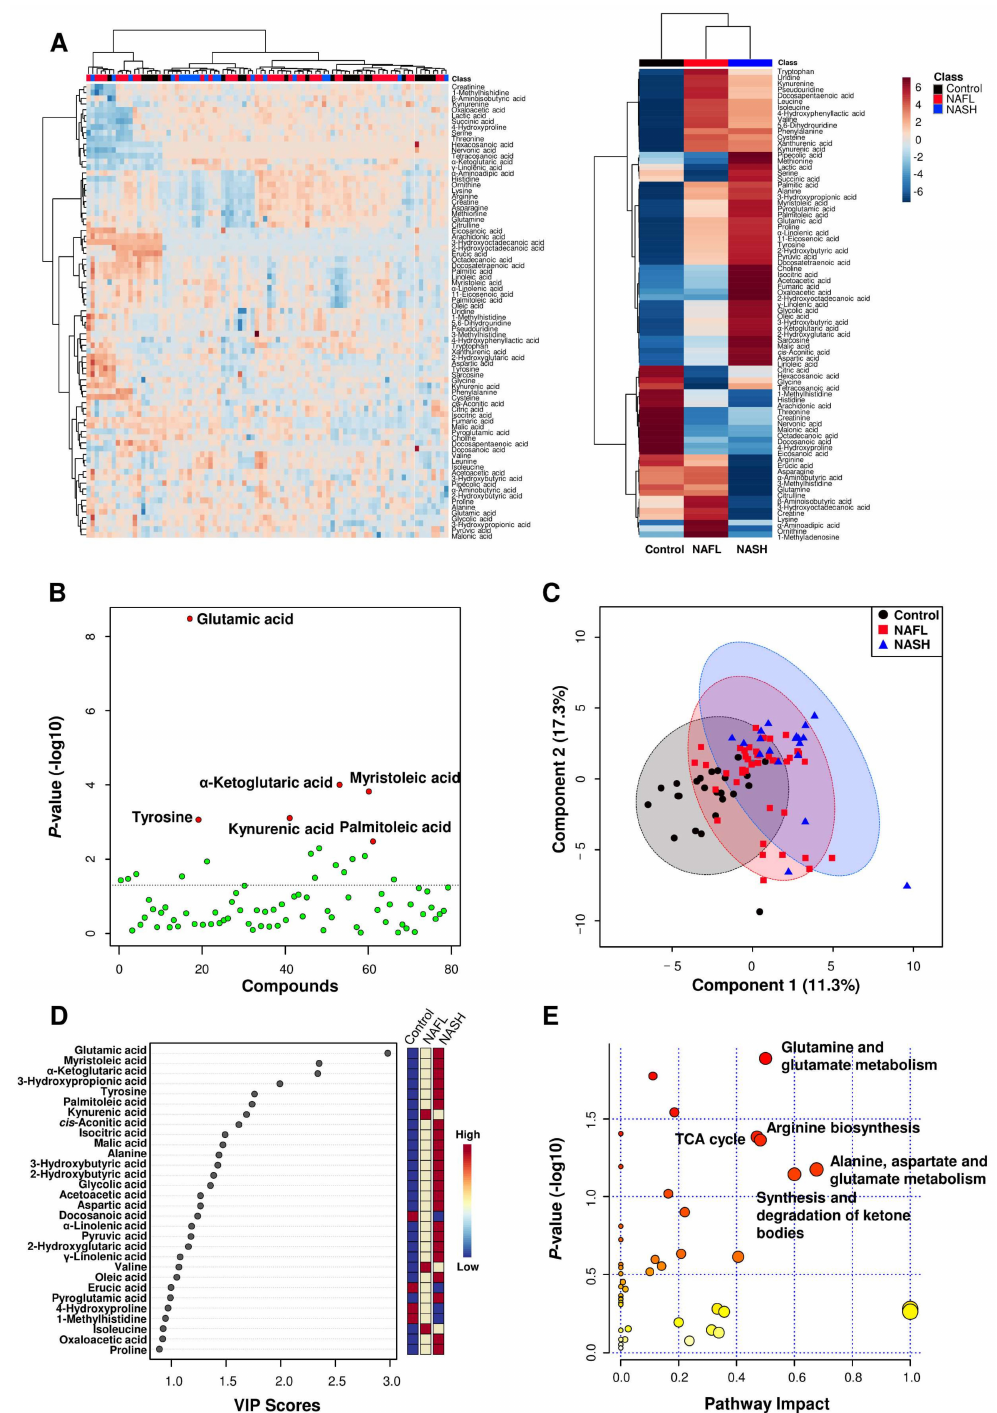
Figure 1. Bioinformatics analyses on plasma metabolite data in the healthy, NAFL, and NASH groups. ( A ) Hierarchical clustering heatmaps showing the normalized plasma metabolite levels (Z scores) of all participants (left) and mean levels of Z scores in each study group (right). ( B ) Scatter plot of the Kruskal-Wallis test. ( C ) PLS-DA score plot of the study groups. ( D ) Variable importance in projection (VIP) plot. ( E ) Bubble plots of altered metabolic pathways related to changes in plasma metabolites in the NASH group versus the NAFL